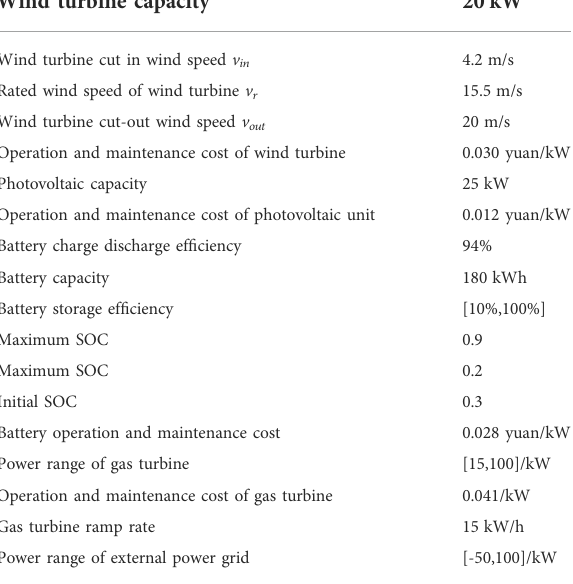
TABLE 1 Parameter setting of Microgrid power supply (Yu and Zheng, 2020).